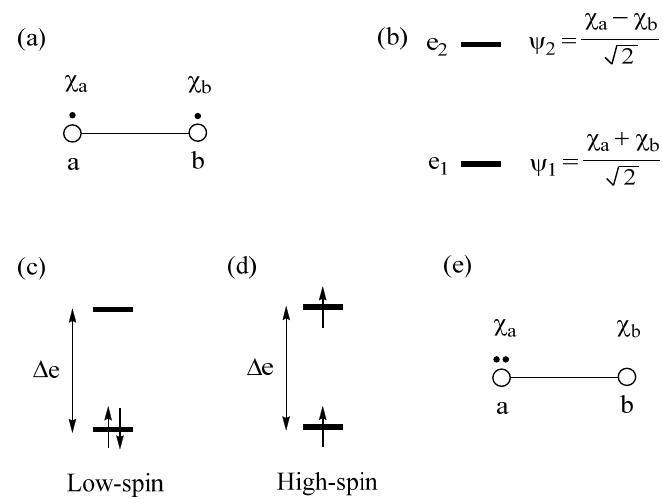
Figure 1. ( a ) A dimer made up of two identical atoms. The AOs at the sites a and b are labeled as χ a and χ b , respectively. ( b ) The bonding and antibonding MOs, ψ 1 and ψ 2 , respectively, separated by energy ∆ e. ( c ) The low-spin state of a dimer. ( d ) The high-spin state of a dimer. ( e ) The double occupation of one AO leading to the on-site repulsion